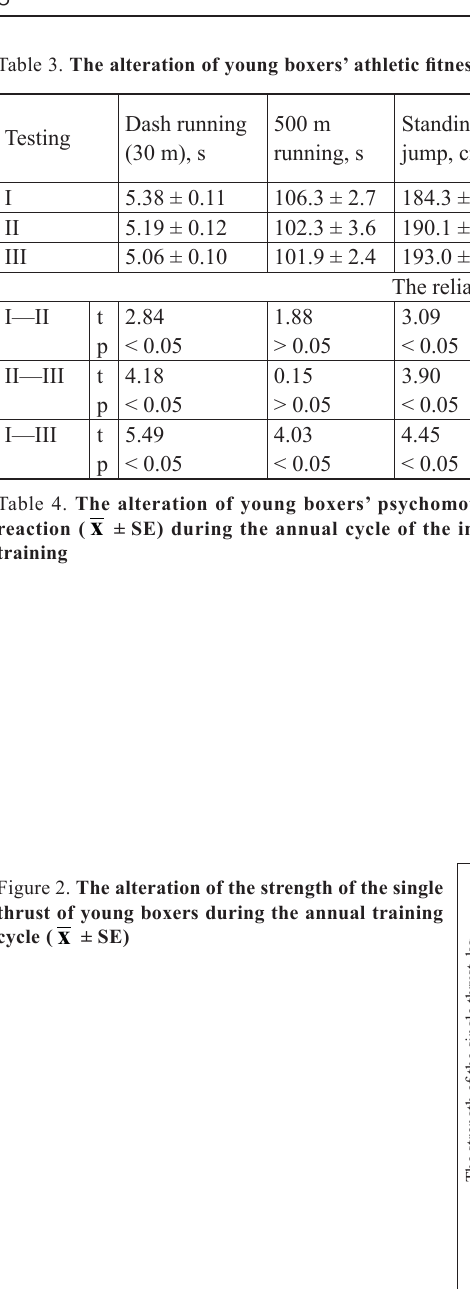
Figure 2. The alteration of the strength of the single thrust of young boxers during the annual training cycle ( x ±